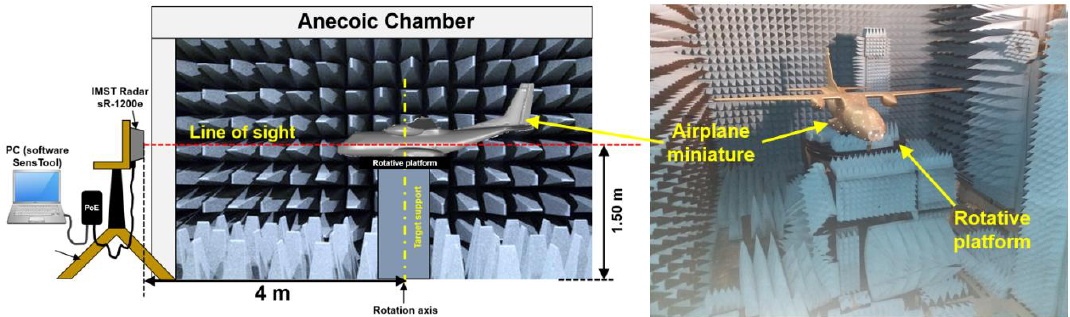
Figure 8. Modified measurement setup for the airplane mock-up.